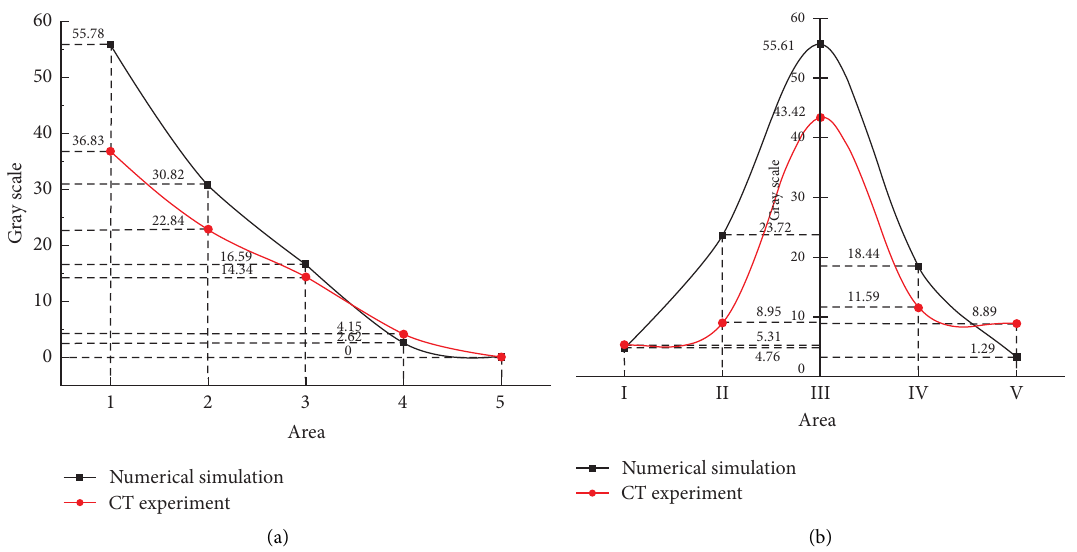
Figure 5: Evolution curve of average gray scale of rock impacted by AWJ. (a) Axial direction. (b) Radial